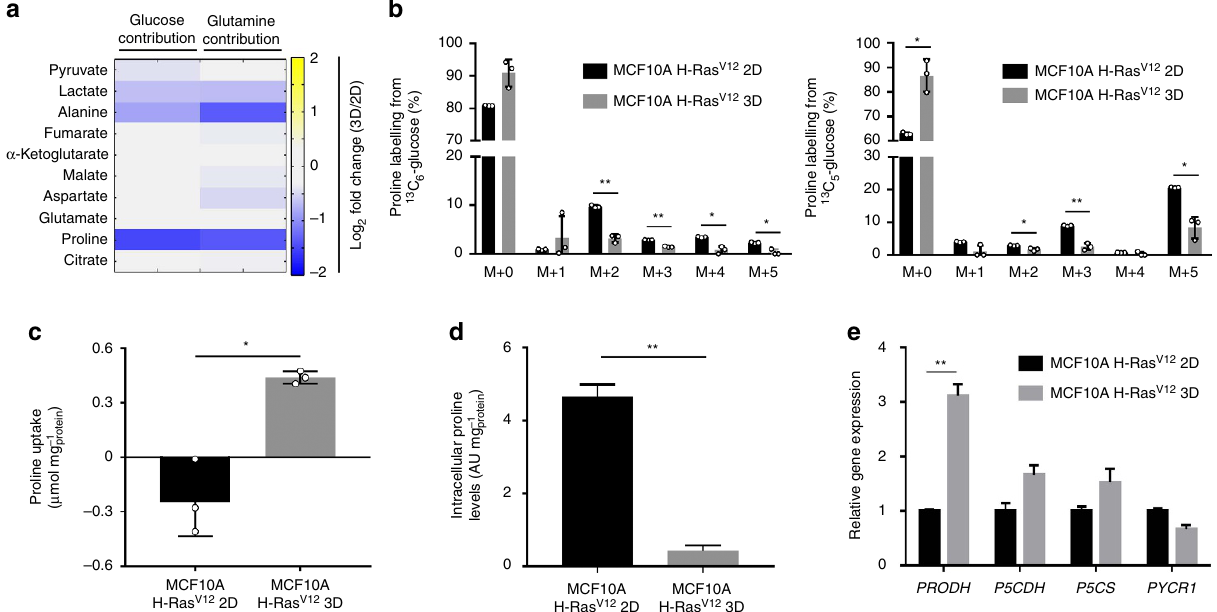
Figure 1 | Proline catabolism distinguishes 3D from 2D growth. ( a ) Total contribution of 13 C 6 -glucose and 13 C 5 -glutamine to different organic acids and amino acids in MCF10A H-Ras V12 spheroids (3D) versus attached cells (2D). Changes in total contribution 4 25% with a P value r 0.05 are depicted. ( b ) Proline labelling from 13 C 6 -glucose and 13 C 5 -glutamine in MCF10A H-Ras V12 spheroids (3D) versus attached cells (2D). ( c ) Proline uptake in MCF10A H-Ras V12 spheroids (3D) versus attached cells (2D). ( d ) Intracellular levels of proline in MCF10A H-Ras V12 spheroids (3D) versus attached cells (2D). ( e ) Relative expression of proline catabolism ( PRODH and P5CDH ) and biosynthesis ( P5CS and PYCR1 ) genes in MCF10A H-Ras V12 spheroids (3D) versus attached cells (2D) measured by qRT–PCR. The number of biological replicates for each experiment was n Z 3. All error bars represent s.d. Two-tailed unpaired Student’s T -test was performed. * P r 0.05; ** P r